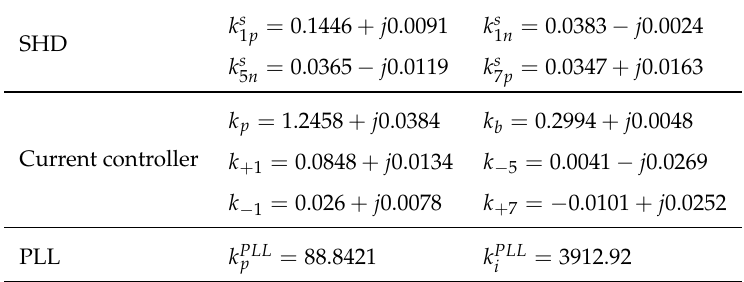
Table 1. Control system details.